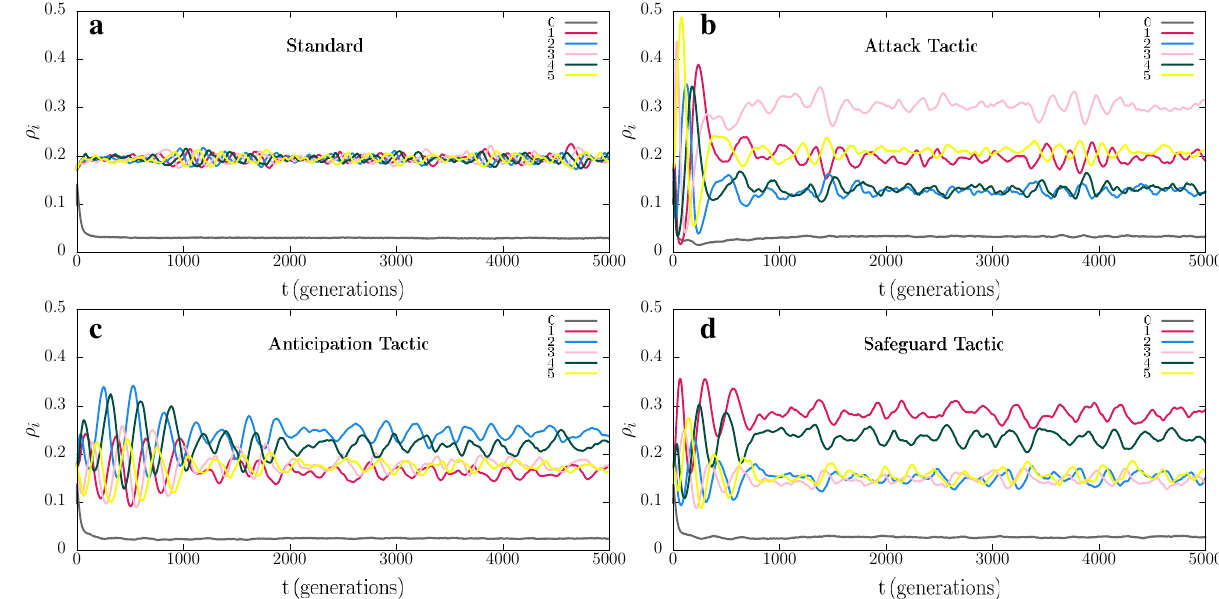
Figure 3. Temporal changes of spatial densities ρ i , with i = 0, 1, 2, 3, 4, 5 , where i = 0 indicates the empty spaces and i = 1, 2, 3, 4, 5 represent the species according to the illustration in Fig. 1. The results were obtained from the simulations presented in Fig. 2. ( a ) Standard case, https:// youtu. be/ Ndvk6 Rg57m4. ( b ) Attack tactic, https:// youtu. be/ JGhkD AHSo74. ( c ) Anticipation tactic, https:// youtu. be/ ZZp9Q lOfv2Q. ( d ) Safeguard tactic, https:// youtu. be/ eFxWd LhIOuQ.